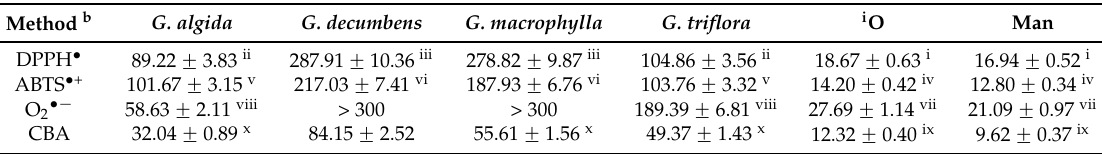
Table 5. Antioxidant activity of four bitter gentian tea decoctions, isoorientin ( i O) and mangiferin (Man), IC 50 , µ g/mL a